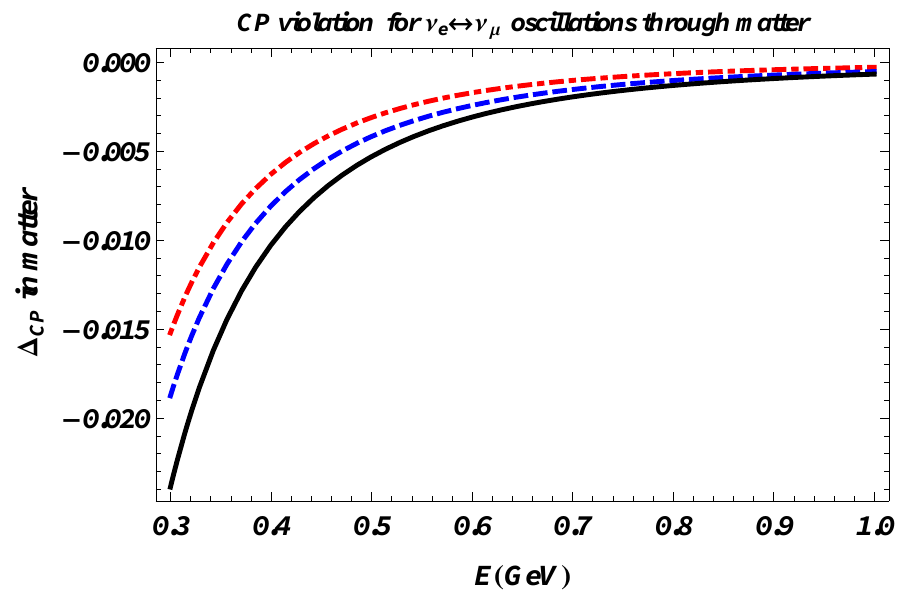
( t ) − P ( t ) , for Majorana neutrinos (the red dot Figure 5. (Color online) Plots of ∆ CP = P ν ν e → ν e e → ν e dashed line) and Dirac neutrinos (the blue dashed line), in matter and in presence of decoherence with off-diagonal term, and for neutrinos in matter in absence of decoherence (the black dotted line). In the plots, we consider the same parameters of Figure 4 and the energy range E ∈ (0.3–1)